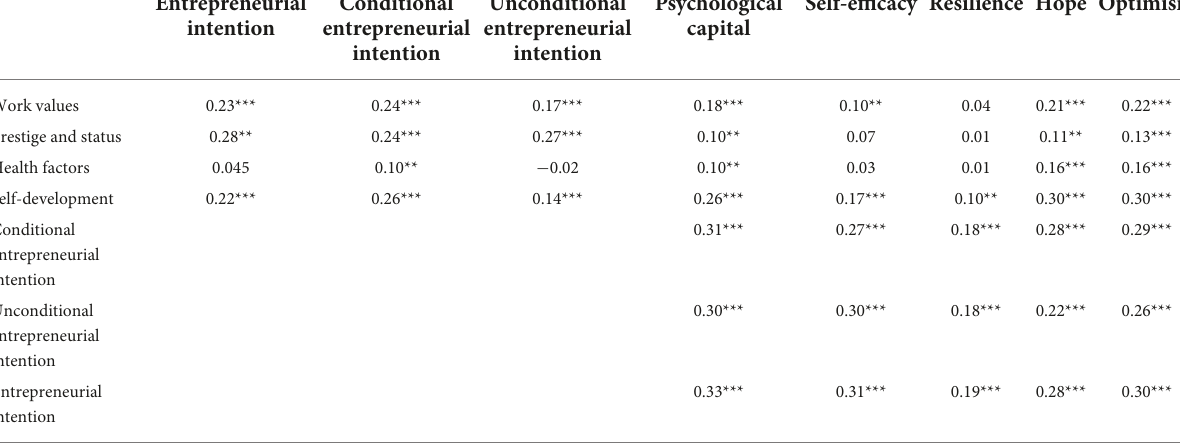
TABLE 3 Correlations among work values, psychological capital, and entrepreneurial